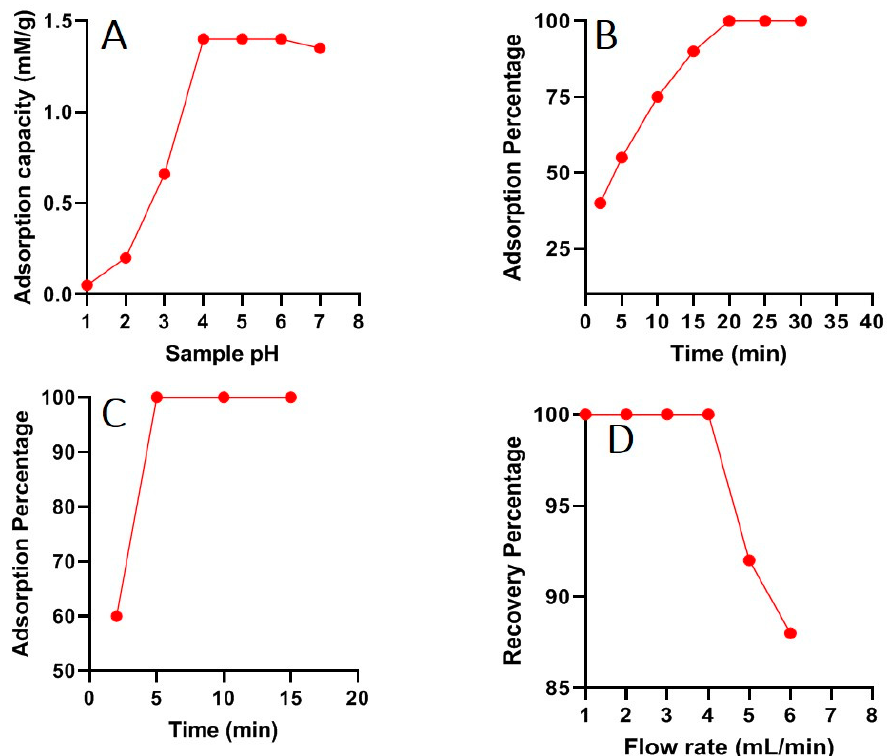
Figure 5. ( A ) Effect of solution pH on the sorption of Hg(II) (sample volume 50 mL; metal ion 100 mg L − 1 ; contact time 30 min; sorbent amount 25.0 mg); ( B ) Effect of sample volume on the preconcentration on Hg(II) at higher sample volume (500 mL) and ( C ) at lower sample volume (100 mL) (metal ion 1 mg L − 1 ; sample pH 5.0; sorbent amount 25.0 mg); ( D ) Effect of sample flow rate on the recovery of Hg(II) (sample volume 100 mL; metal ion 1 mg L − 1 ; sample pH 5.0; sorbent amount 25.0 mg).